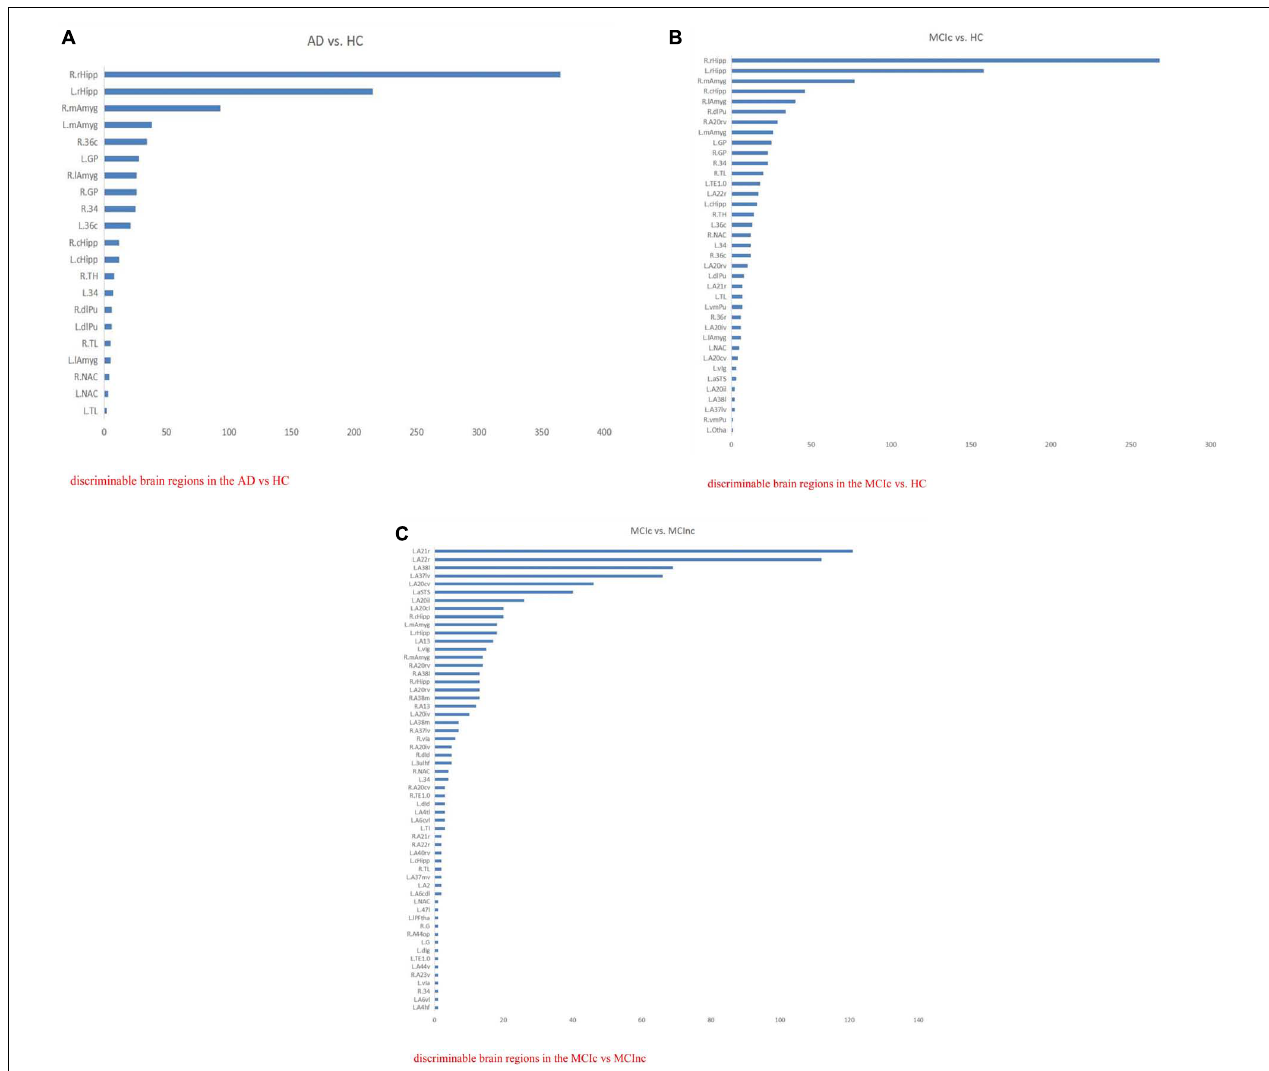
FIGURE 8 | The list of brain regions with the classification capacity in each classification task. (A) Discriminable brain regions in the AD vs. HC. (B) Discriminable brain regions in the MCIc vs. HC. (C) Discriminable brain regions in the MCIc vs. MCInc.